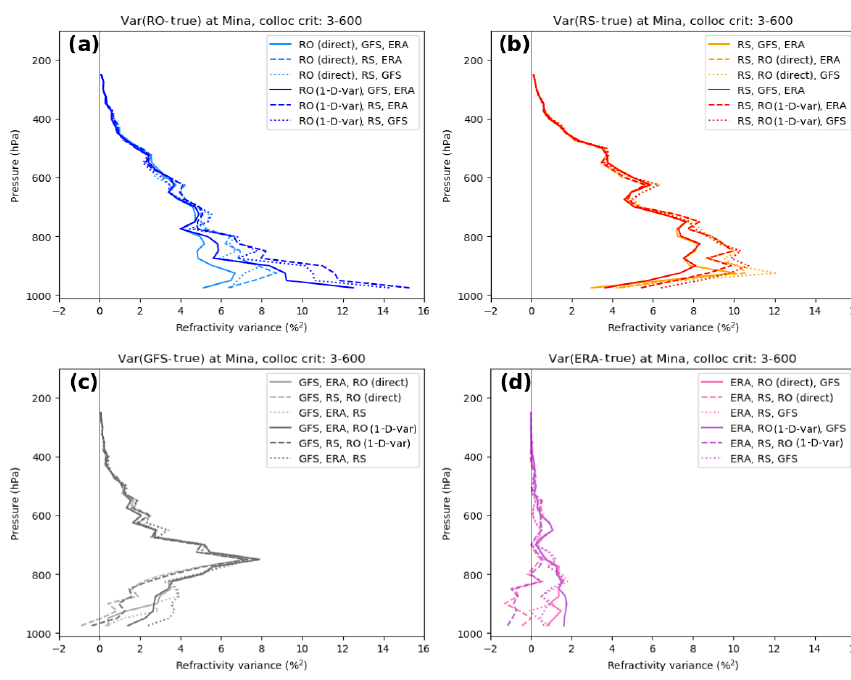
Figure 9. Estimated error variances (percent squared) of refractivity at Mina: (a) RO, (b) RS, (c) GFS, and (d) ERA.